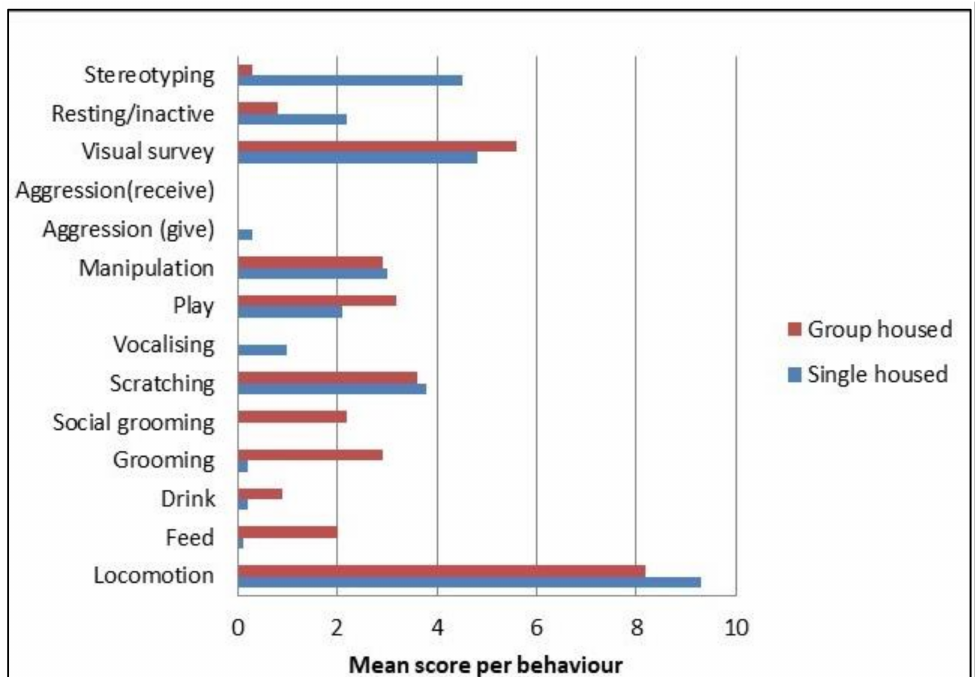
Figure 3. Mean number of observations for typical NHP behaviors over a seven-day observational period for single- and group-housed ( n = 3) NHPs (further details on the validation study and results are provided within